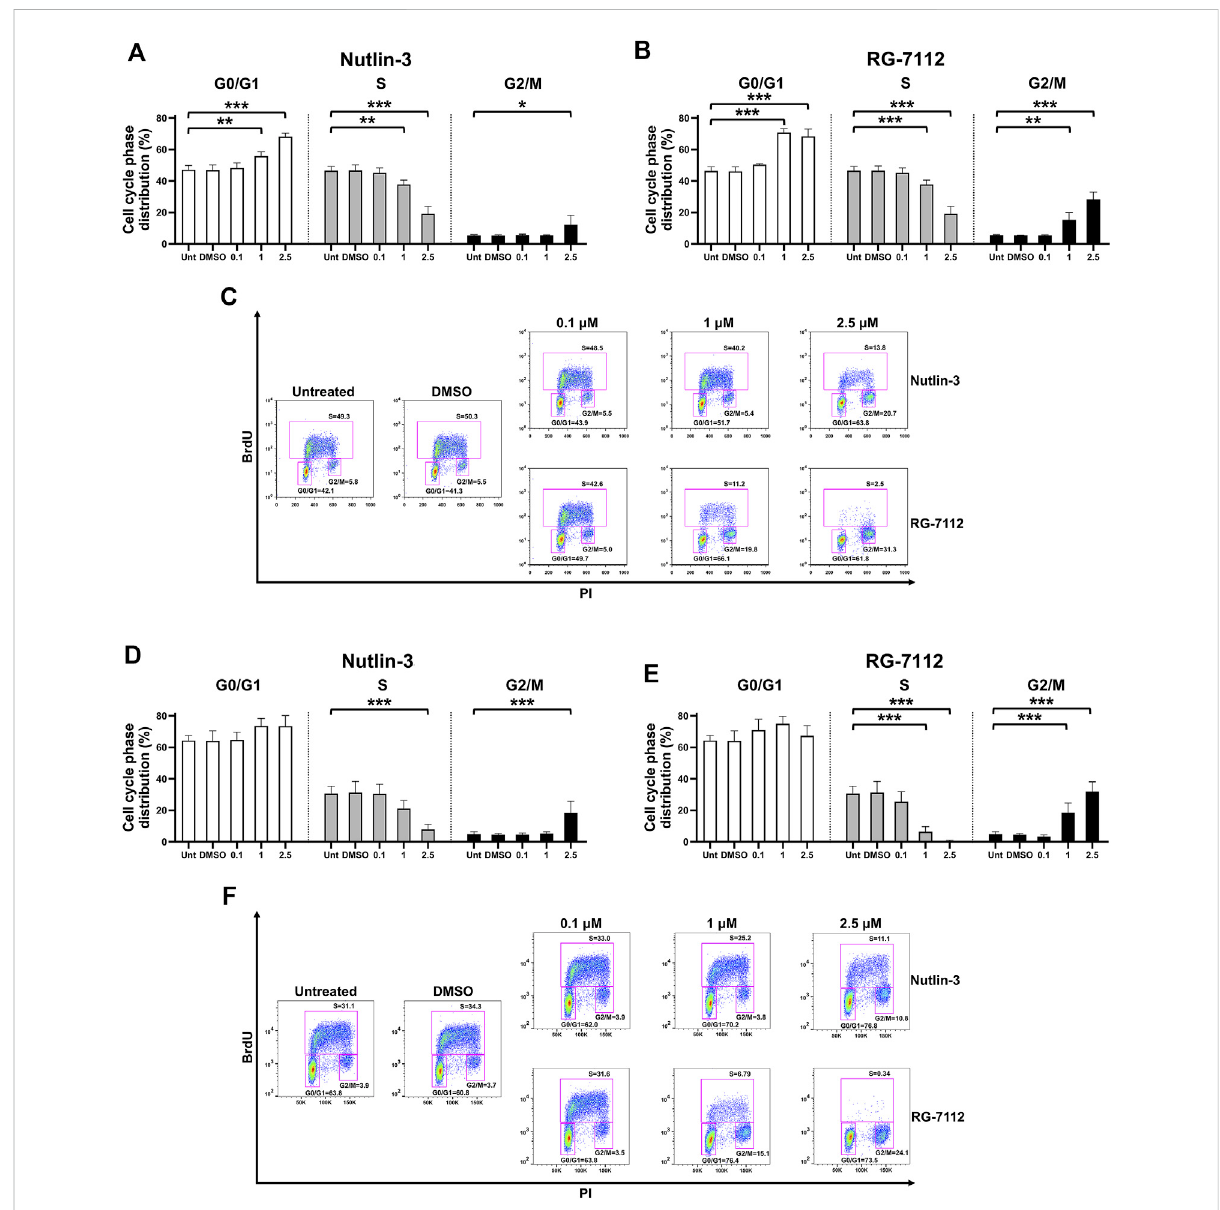
MDM2 inhibitors block cell cycle of alveolar basal epithelial cells. A549-hACE2 cells distribution in the different phases of the cell cycle calculated from cytometry dot plot deriving from BrdU/PI staining of cultures treated with different concentrations (µM) of Nutlin-3 or RG-7112 for 24 (A – C) and 72 h (D – F) . Results are expressed as percentage of total population and data are reported as mean ± standard error of the mean from three independent experiments. DMSO is reported as control vehicle. Statistical analysis was performed by ANOVA followed Bonferroni ’ s